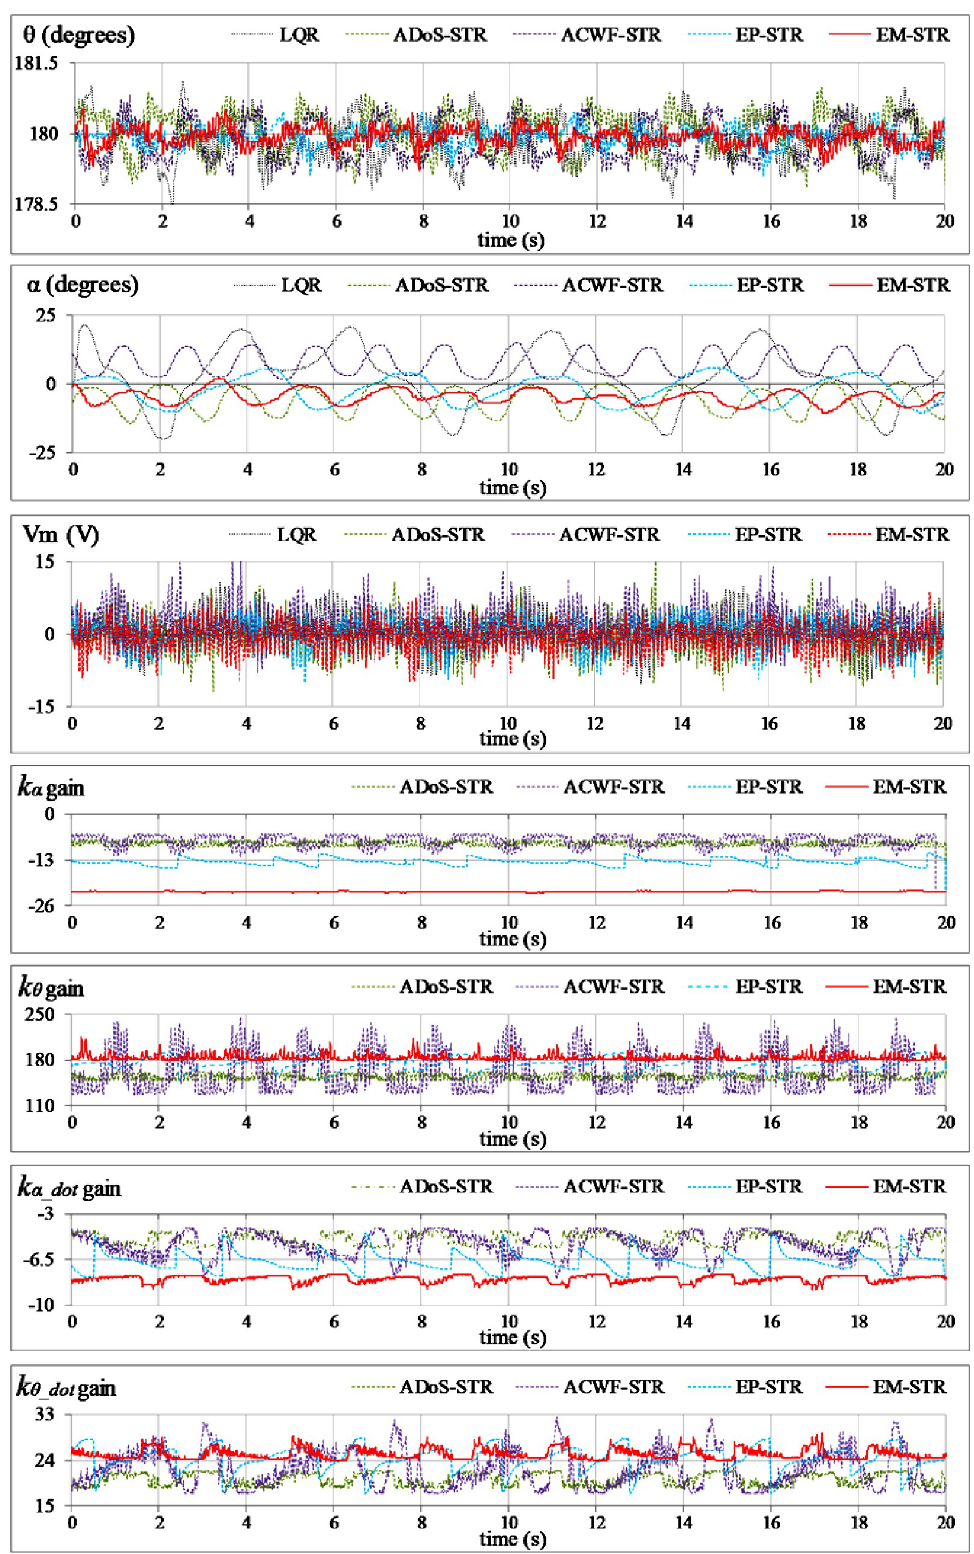
Fig 15. Pendulum’s response under sinusoidal disturbance.